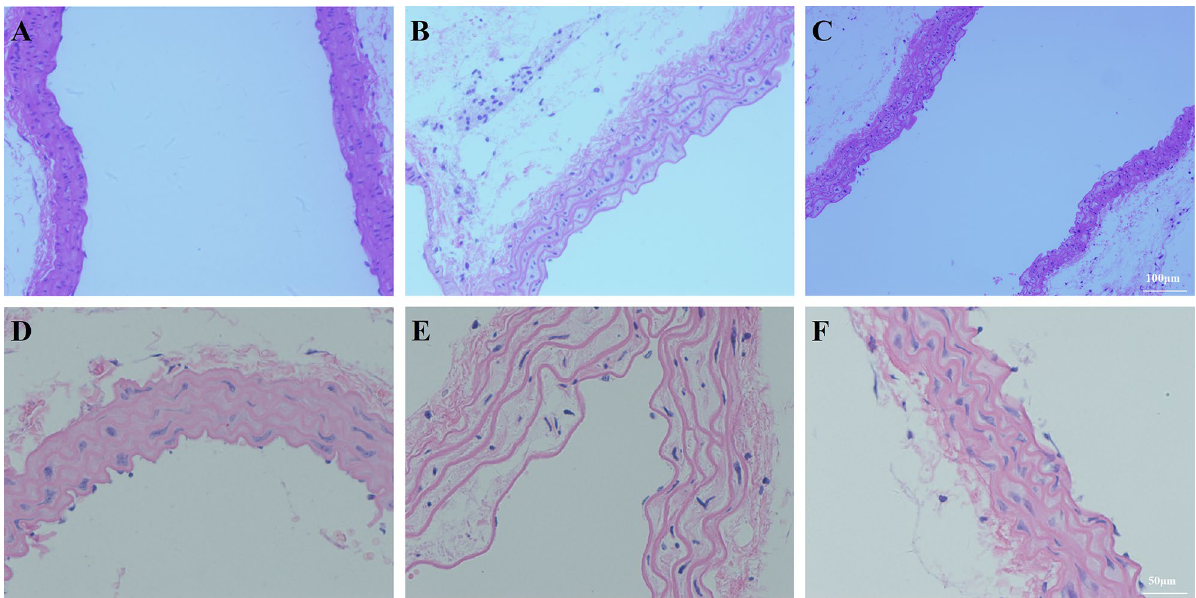
Figure 9. BM-MSCs improved LPS-induced aortic tissues at 48 h after LPS treatment. ( A , D ) Sham group. ( B , E ) LPS group. ( C , F ) LPS + MSC group. ( A – C , ×100 magnification. D – F , ×200